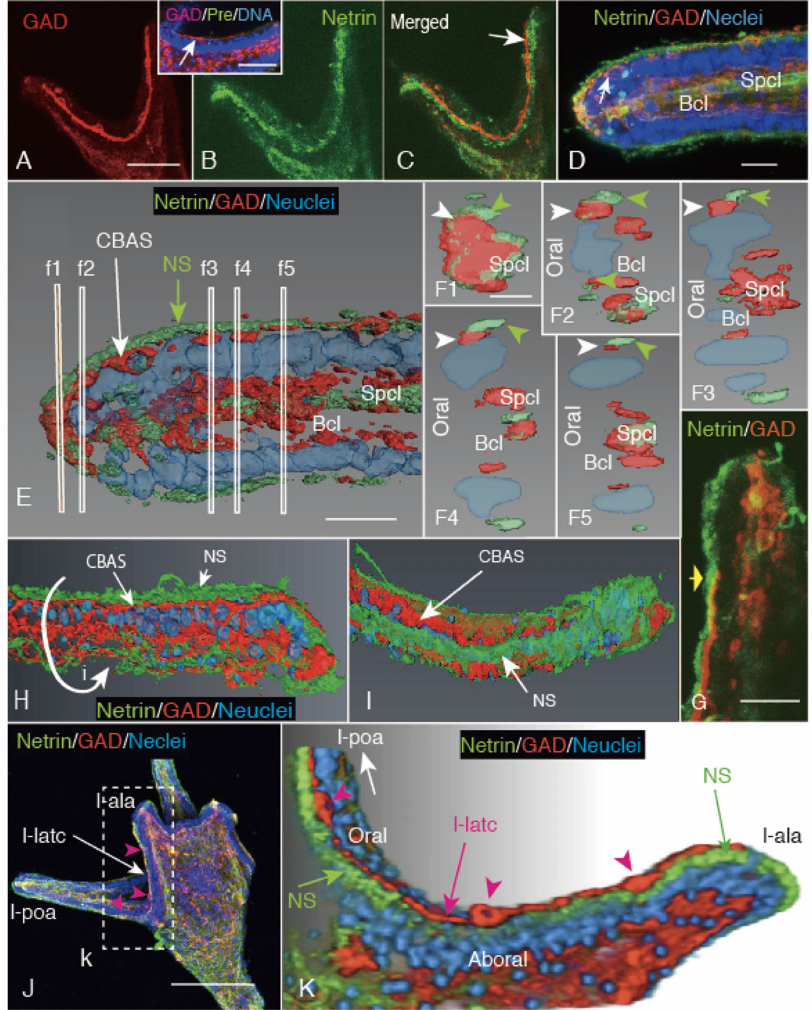
Figure 5. Pattern formation of GAD-positive CBAS (red) along the Netrin-positive stripe in 4aPL. ( A ) Confocal laser scanning microcopy (CLSM) of the post-oral CBAS (poc). ( B ) The Netrin stripe along the poc. ( C ) Merged image between (A) and (B). Inset: pre-immune serum of anti-Netrin Ab applied poc (arrow) area. ( D ) CLSM of a post-oral arm region. Netrin (green) layer was on the apical surface and on the spicule surface (Spcl) in the blastocoel (Bcl). GAD-positive CBAS (red) is seen beneath the Netrin-positive layer on the apical surface (arrow). ( E ) 3D-reconstructed image of (D). Thin vertical rectangles locate the following cross-sectional images of the area shown by (F1) to (F5). ( F1 – F5 ) These cross sections consistently located the CBAS (white arrowheads) on the circumoral ectoderm side of the Netrin strip (green arrowheads), as is seen with the flat oval cut-surface. ( G ) CLSM of a longitudinal center line section of a post-oral arm used for 3D-reconstruction images (H) and (I). ( H ) The CBAS (red) is seen beneath the Netrin-positive layer (NS, green). ( I ) 3D image of (G) that was tilted along the curved arrow in (H) showing the arm surface from the direction pointed by a yellow arrow in (G), indicating the Netrin stripe (NS) on the CBAS. ( J ) CLSM of the whole-body of the aboral side of a larva, and the left-lateral CBAS (l-latc) extends from the left antero-lateral arm (l-ala) to the left post-oral arm (l-poa). (* K ) 3D image of (J) shown by a rectangle (k) in (D) locates l-latc (red) between the Netrin stripe (NS) and circumoral ectoderm area (Oral). Scale Bars = 25 µ m (A), 10 µ m (D, E, F1), 25 µ m (G). * Refer to Supplemental Figure